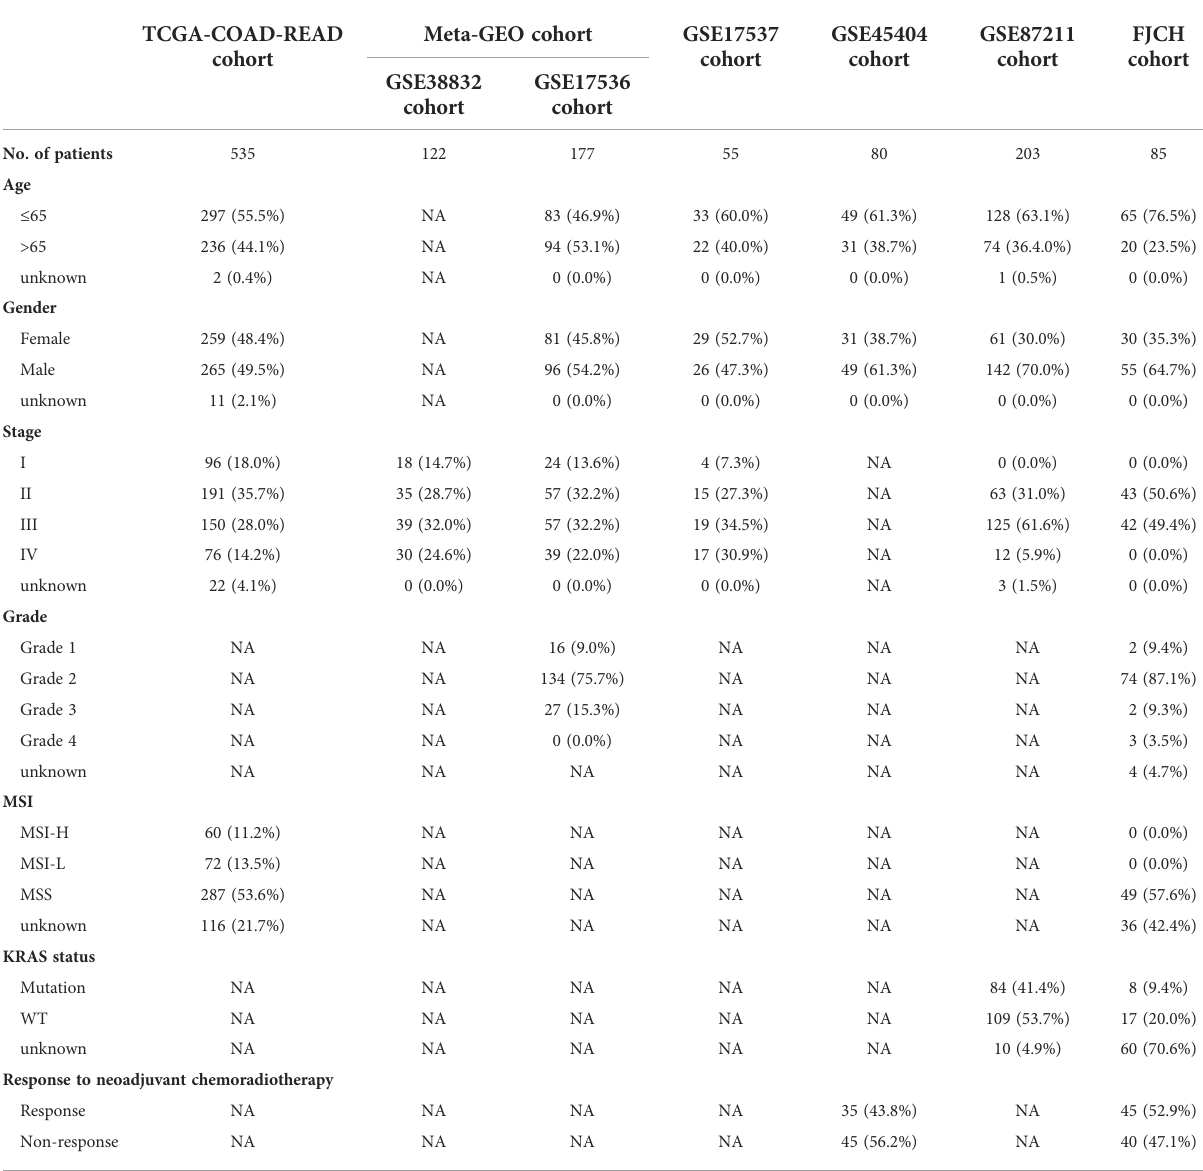
TABLE 1 Clinical characteristics of the CRC patients used in this